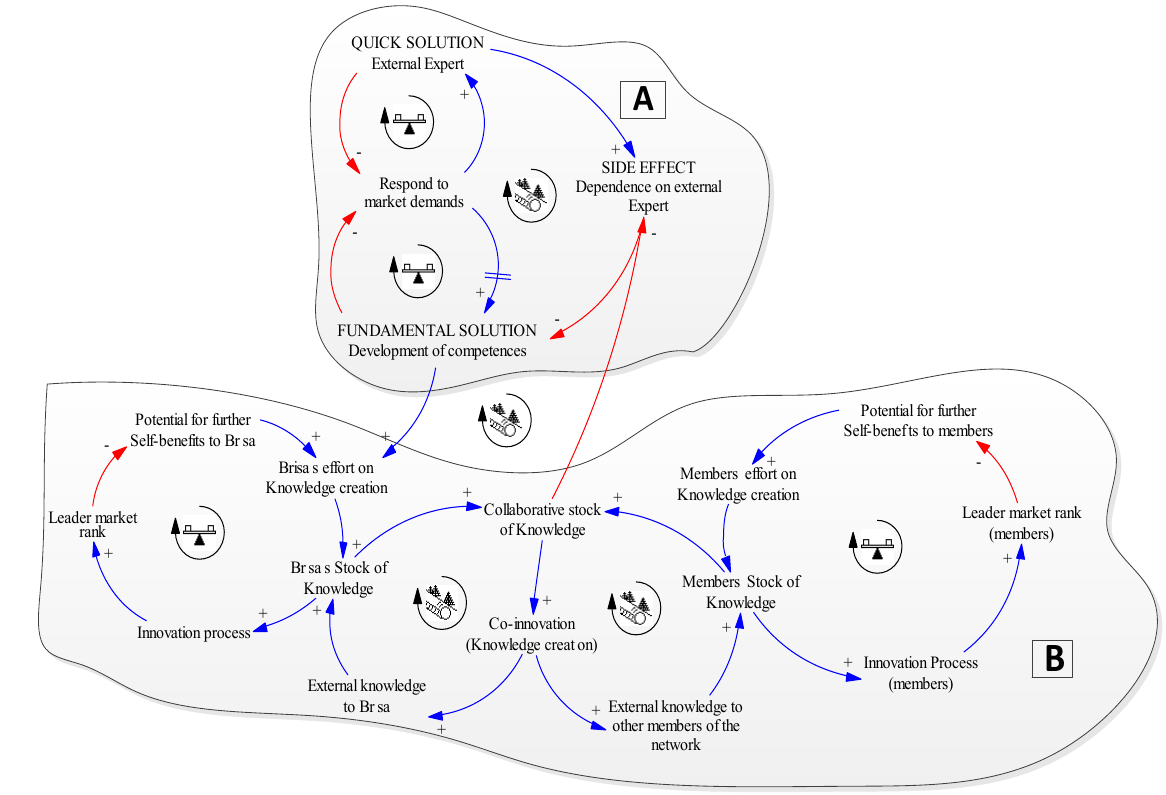
Figure 3: (a, b) – Causal Loop